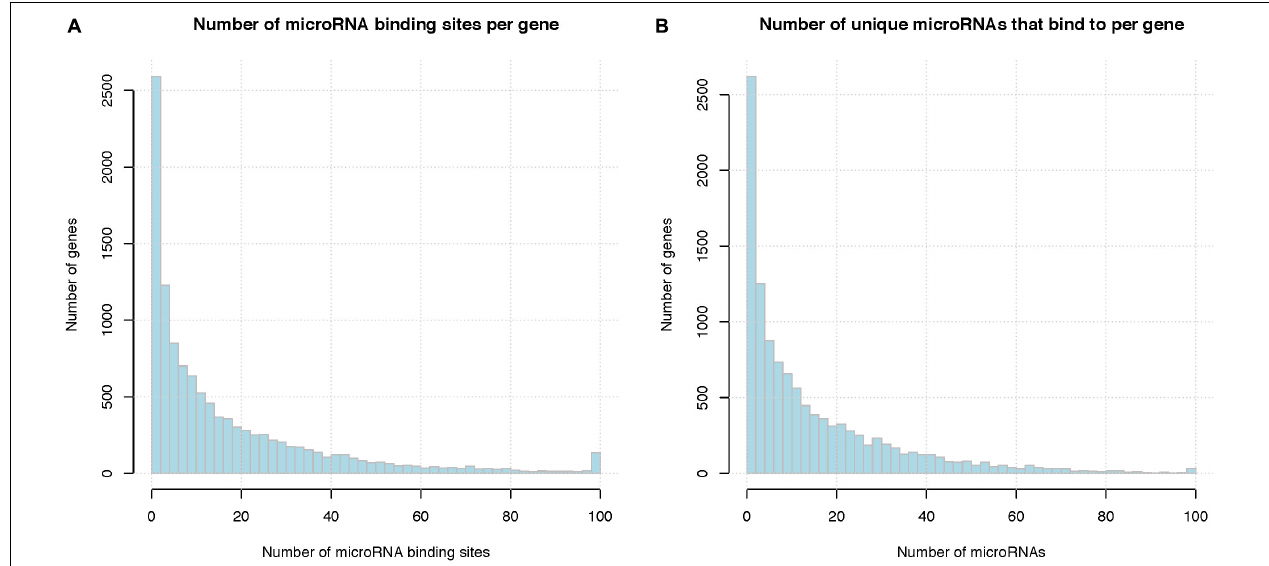
FIGURE 5 | Summary of microRNA binding sites. (A) Total number of microRNA binding sites per gene, binding sites of different microRNAs are pooled together. X -axis represents the number of microRNA binding sites per gene and the last column represents the number of genes with binding sites greater than 100, Y -axis indicates the number of genes that have that number of microRNA binding sites. (B) Number of unique microRNAs that bind to a human gene. X -axis represents the number of microRNA binding sites per gene and the last column represents the number of genes with binding sites greater than 100, Y -axis indicates the number of